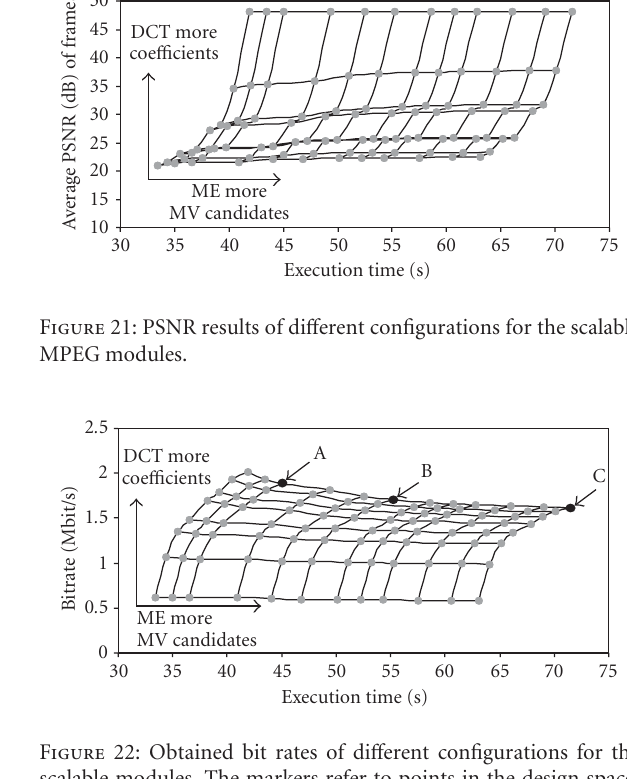
Figure 22: Obtained bit rates of di ff erent configurations for the scalable modules. The markers refer to points in the design space, where the same bit rate and quality (not computational complex- ity) is obtained as resulting from using diamond search (A) or full search with a 32 × 32 (B) or 64 × 64 (C) search area for